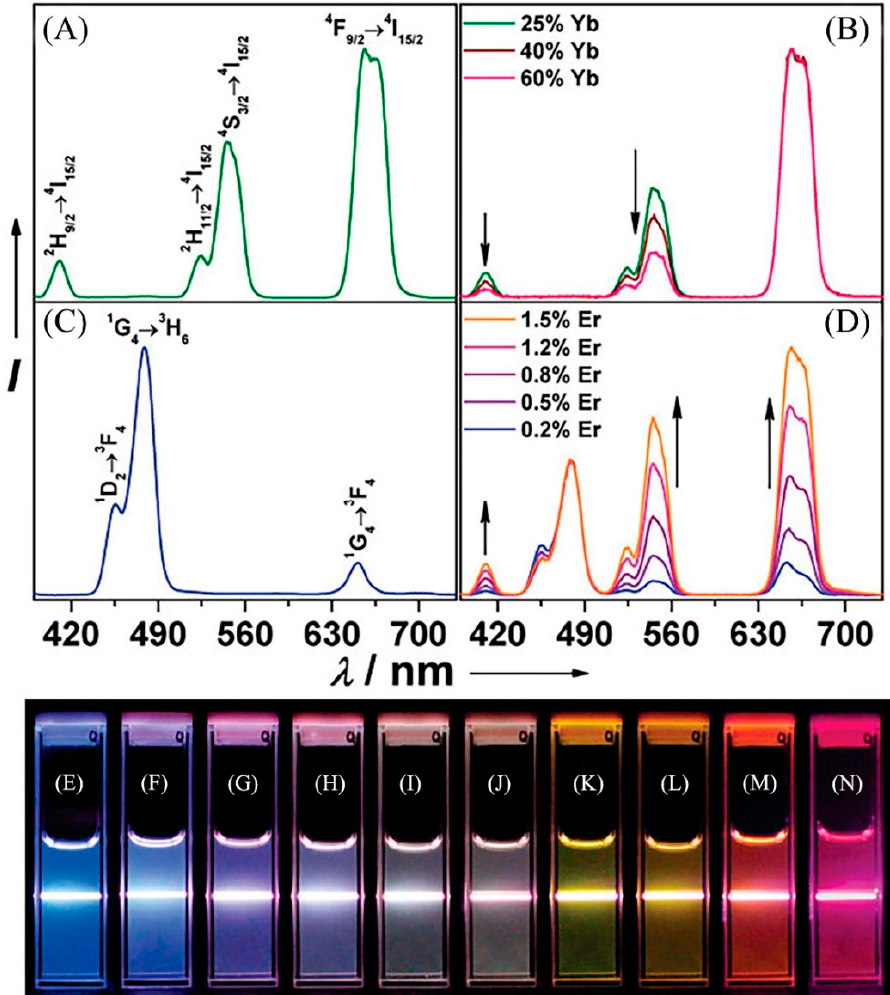
Figure 1. Room temperature upconversion emission spectra of ( A ) NaYF 4 : Yb, Er (18/2 mol%), ( B ) NaYF 4 : Yb, Tm (20/0.2 mol%), ( C ) NaYF 4 : Yb, Er (25–60/2 mol%), and ( D ) NaYF 4 : Yb, Tm, Er (20/0.2/0.2–1.5 mol%) particles in ethanol solutions (10 mM). The spectra in ( C ) and ( D ) were normalized to Er 3+ 650 nm and Tm · 480 nm emissions, respectively. Compiled luminescent photos showing corresponding colloidal solutions of ( E ) NaYF 4 : Yb, Tm (20/0.2 mol%), ( F – J ) NaYF 4 : Yb, Tm, Er (20/0.2/0.2–1.5 mol%), and ( K – N ) NaYF 4 : Yb, Er (18–60/2 mol%). The samples were excited at 980 nm with a 600 mW diode laser. The photographs were taken with exposure times of 3.2 s for ( E – I ) and 10 s for ( M , N ). Reprinted with permission from [7], copyright 2008, American Chemical